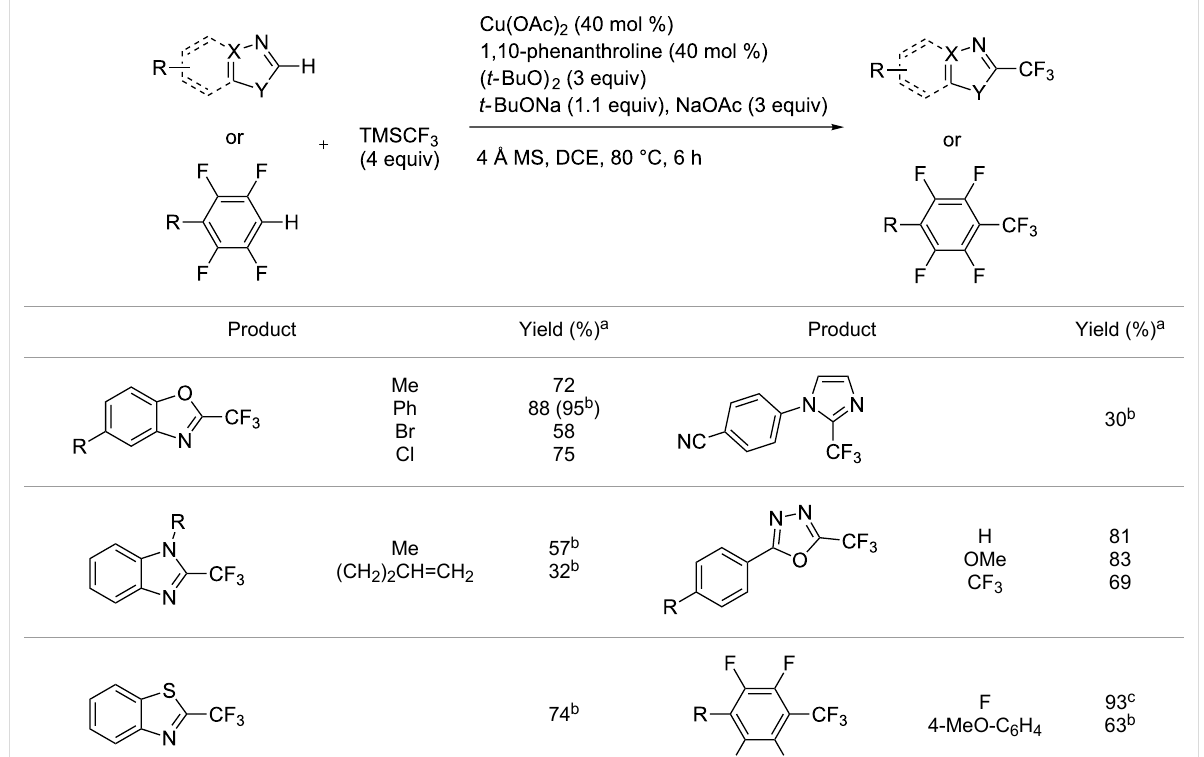
Table 21: Extension of Qing’s Cu-catalyzed trifluoromethylation to benzo[ d ]oxazoles, benzo[ d ]imidazoles, benzo[ d ]thiazoles, imidazoles and polyfluo- robenzenes